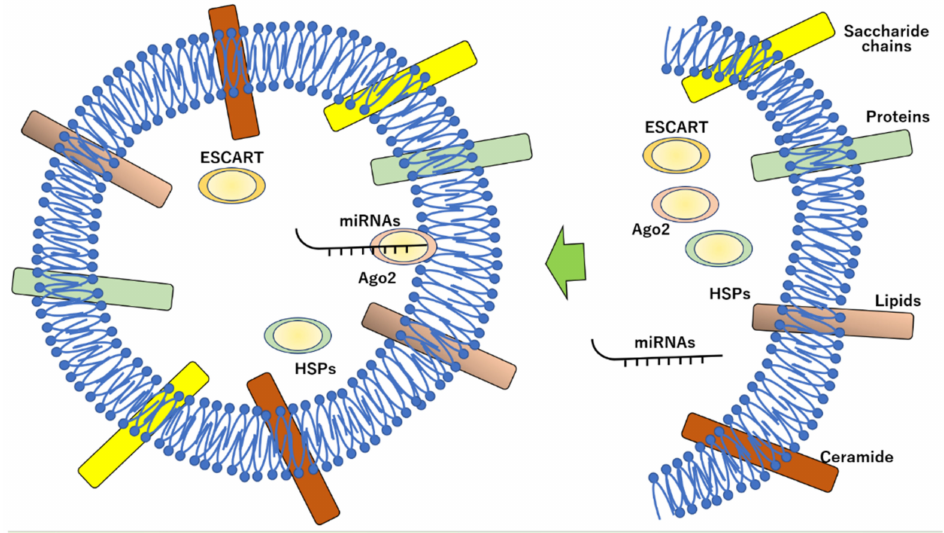
Figure 1. The exosome formation and structure with components. The exosome is constituted by bi-layer membranes, on which some molecules, such as cermide, lipid, prorein, and saccharide, are located. Some proteins, HSPs, Ago2, and ESCART, and miRNAs are encapsulated during formation of